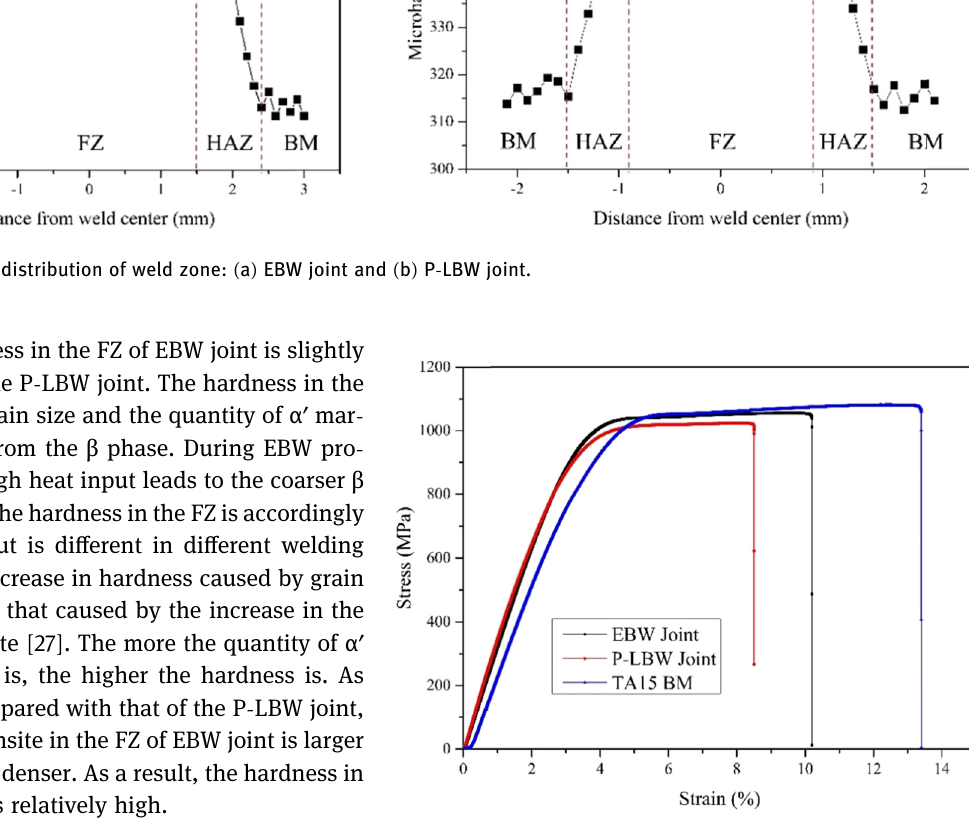
Figure 12: Tensile stress – strain curves of base metal and welded